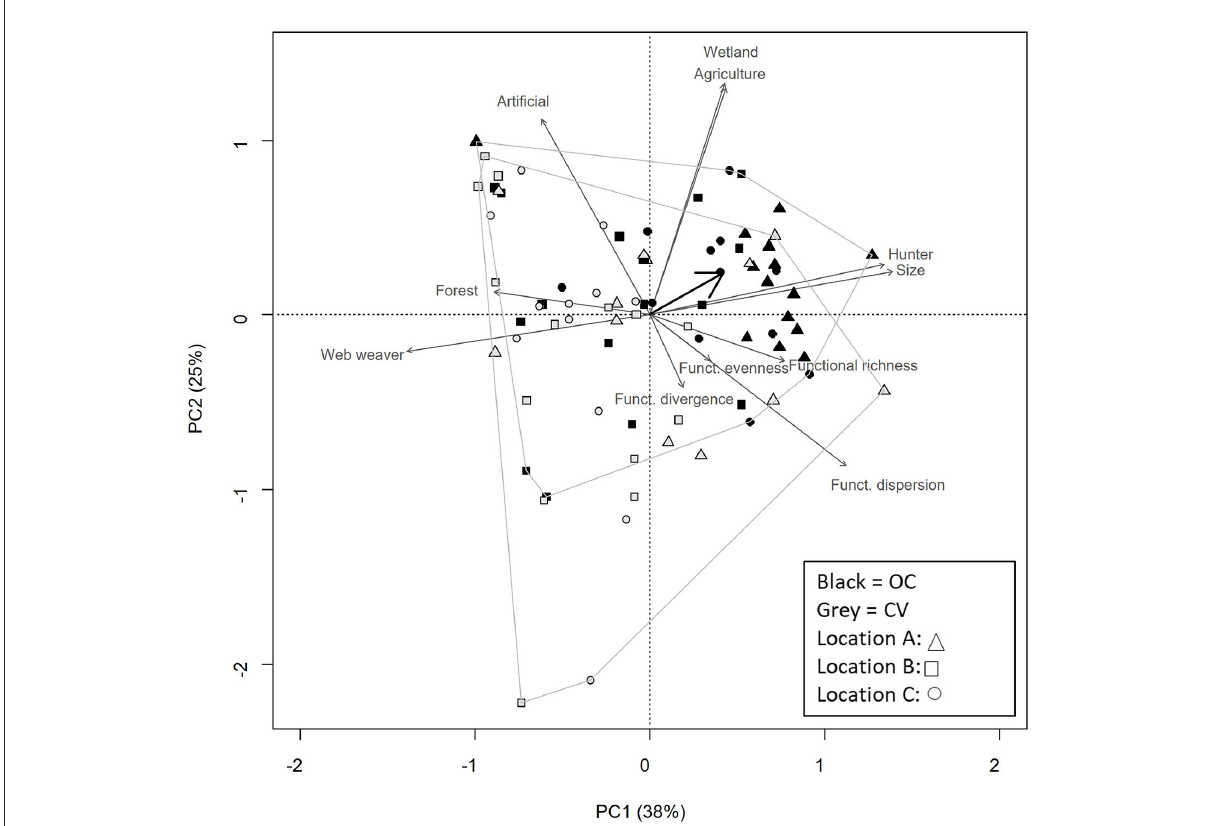
FIGURE5 Principal Component Analysis of CWM-traits attributes and functional diversity indices of spider community in organic-conservation (black) and conventional (gray) parcels. Shapes indicate the three sampling locations as detailed in legend box. CWM-traits included are: habitat type (agriculture, wetlands, forests and semi natural habitats, caves); mean body size; foraging mode (web weaver or run and kill). The black arrow depicts the system variable, allowing interpretation between trait attributes and farming system type. Each system type is surrounded to help